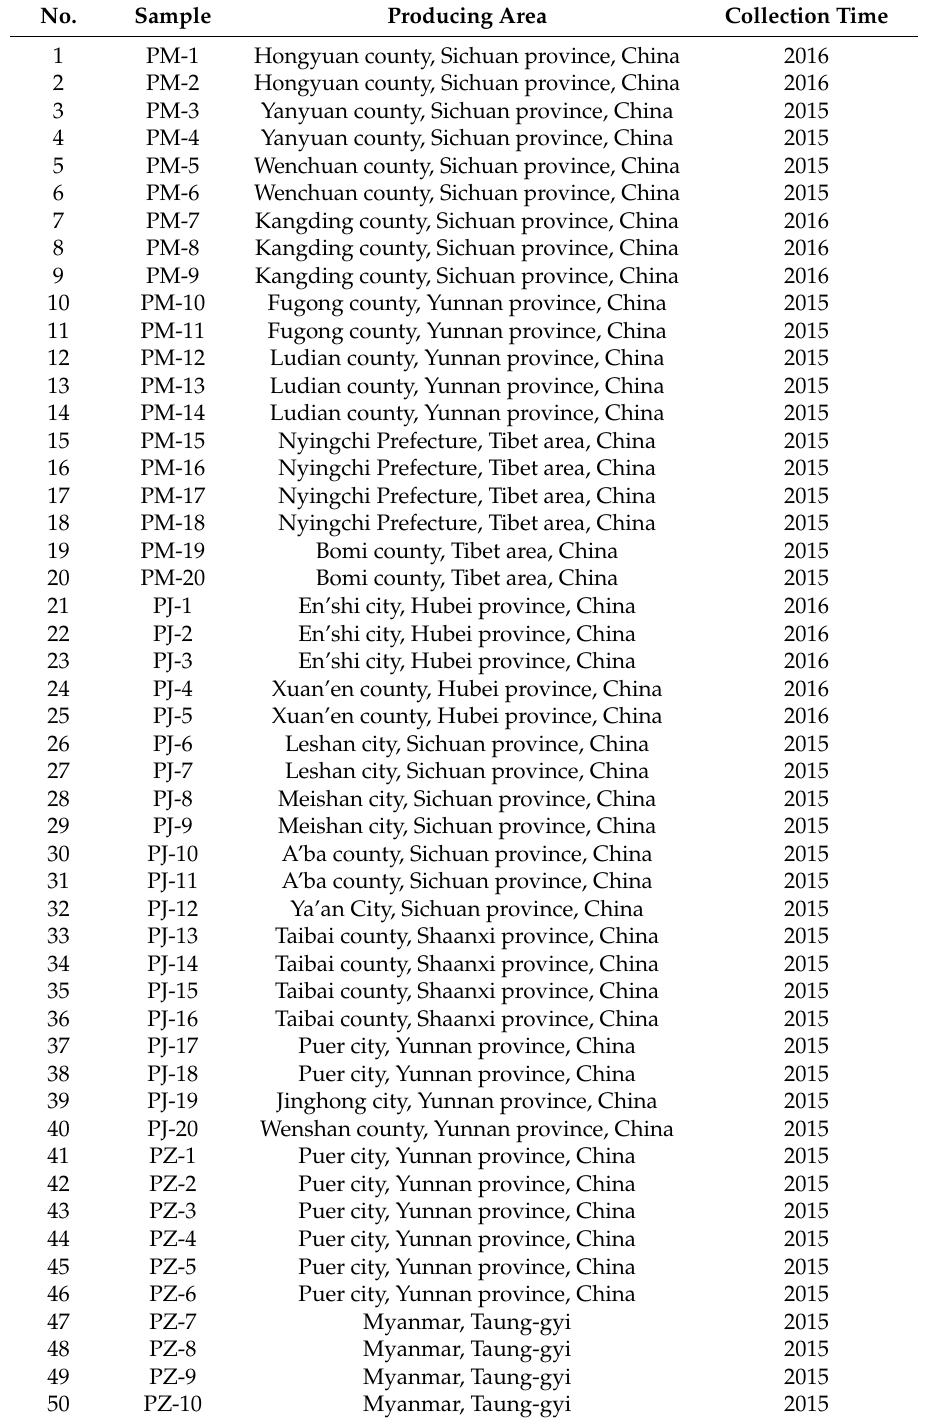
Table 1. The sources of roots and rhizomes of Panax japonicus var. major (PM1–PM20), Panax japonicas (PJ1–PJ20), and Panax zingiberensis